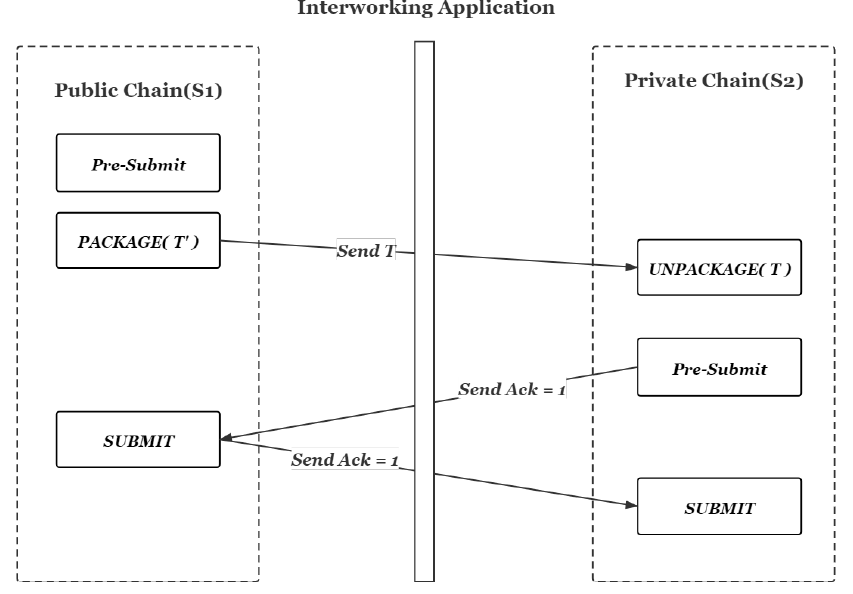
Figure 5. Main chain and sub-chain communication process through interworking application.